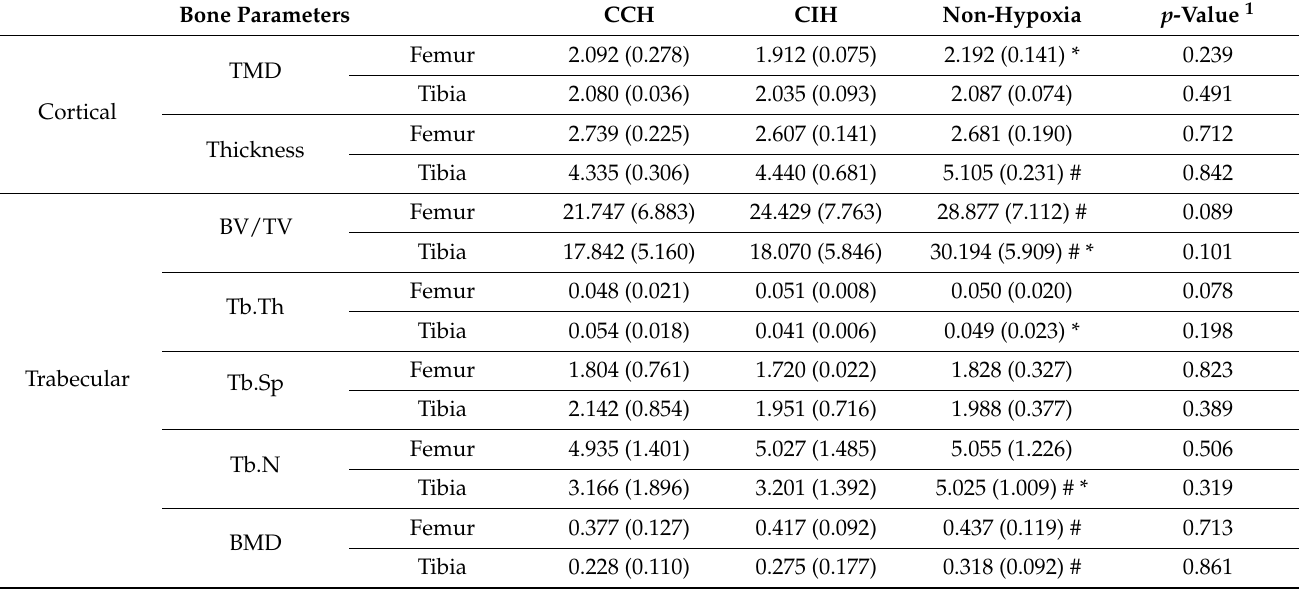
Table 1. Comparison of bone morphometry parameters according to different hypoxic conditions.